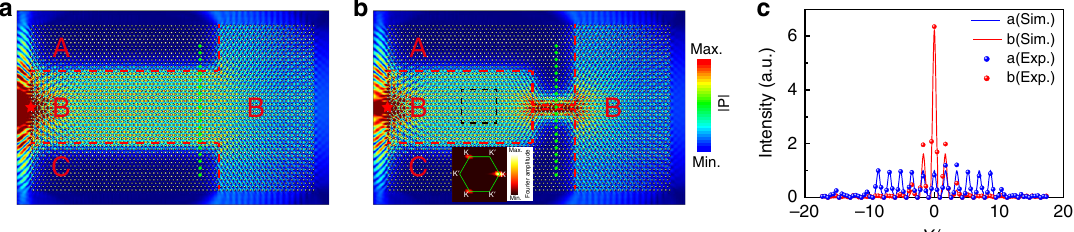
Fig. 5 Valley-locked converging. a , b Simulated acoustic pressure fi eld distribution under 5.45 kHz point excitation on the left of the heterostructure with a uniform B domain of x = 21 ( a ), and with a stepped B domain with x sharply changing from 21 to 1 ( b ). The A, B, and C domains are delineated by the red dashed lines. The inset in b is the simulated Fourier spectrum of the acoustic fi eld in the black dashed rectangle. c The blue circles (blue solid line) and red circles (red solid line) represent the experimental (simulated) intensity pro fi les along the green dotted lines in a and b , Fig. 1, the periodical boundary condition is assumed in the X direction, 49 layers in total for the entire structure (including the x layers for B) are assumed in the Y direction, and rigid boundaries are assumed at the top and bottom. In the simu- lations of the fi eld distributions, e.g., Fig. 1e and Figs. 3 – 5, open boundaries are assumed.